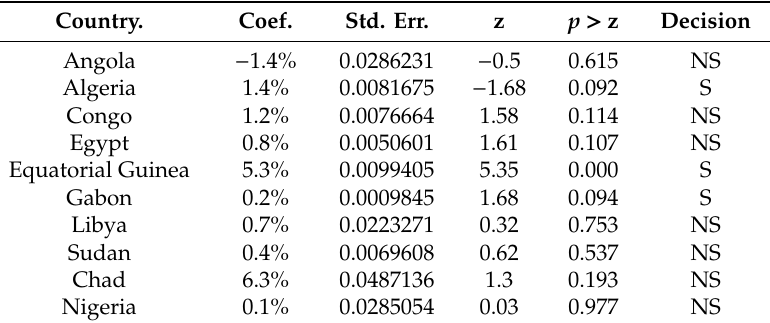
Table 13. Panel ARDL oil revenue, short-run coe ffi cients.